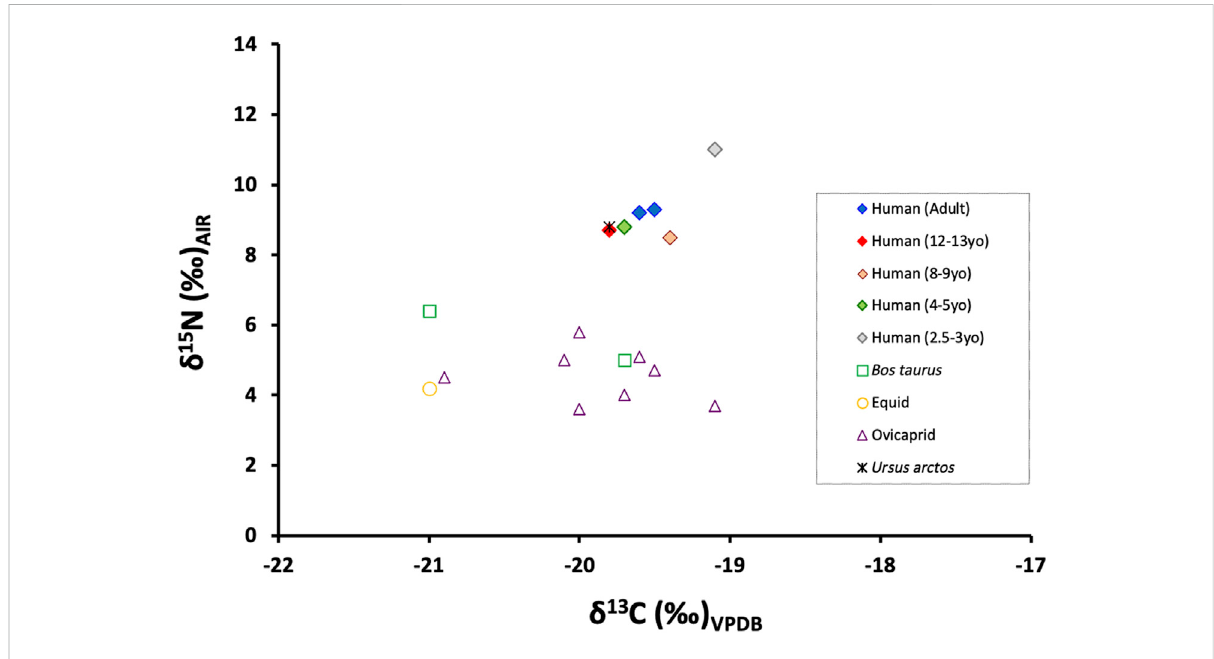
FIGURE 4 Plot of human and animal bone collagen δ 13 C and δ 15 N values from Cova Bonica.